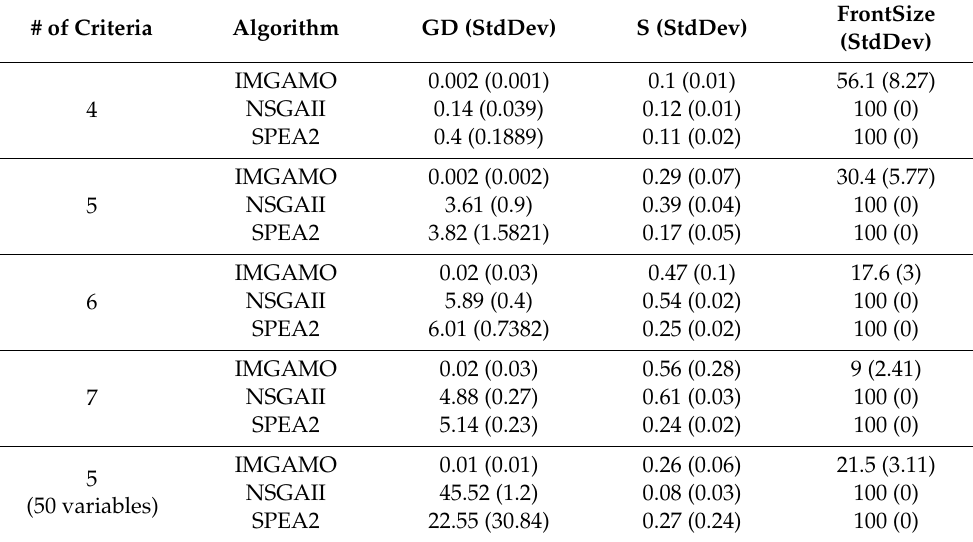
Table A7. Comparison of results for DTLZ4 problem.